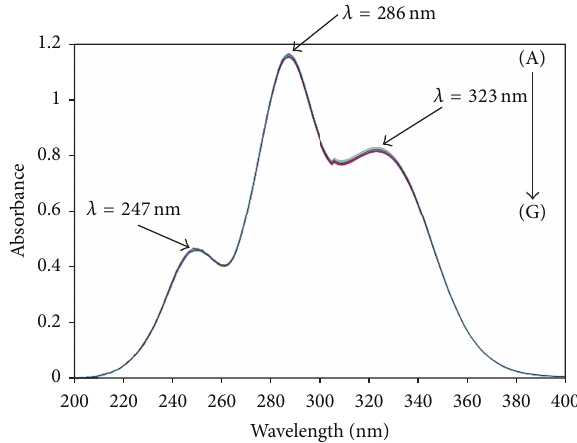
Figure 3: Absorption spectra of Oxy (3.17mM) in methanol/water mixture (85:15, v/v) as a function of 𝛽 -CD’s concentration at 25 ∘ C. [ 𝛽 -CD] (M): (A) 0; (B) 1.56; (C) 3.13; (D) 4.69; (E) 6.25; (F) 7.81; (G) 9.37. Stirring time: 6